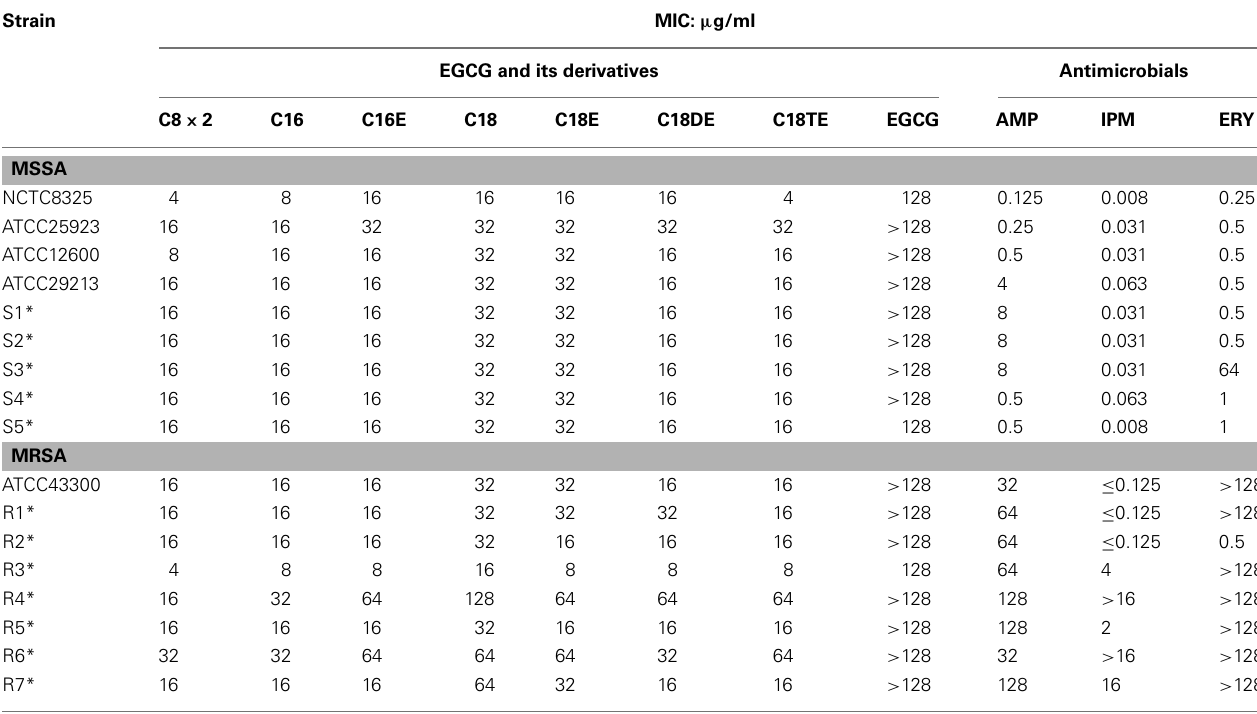
Table 2 | MICs of EGCG derivatives for S. aureus .